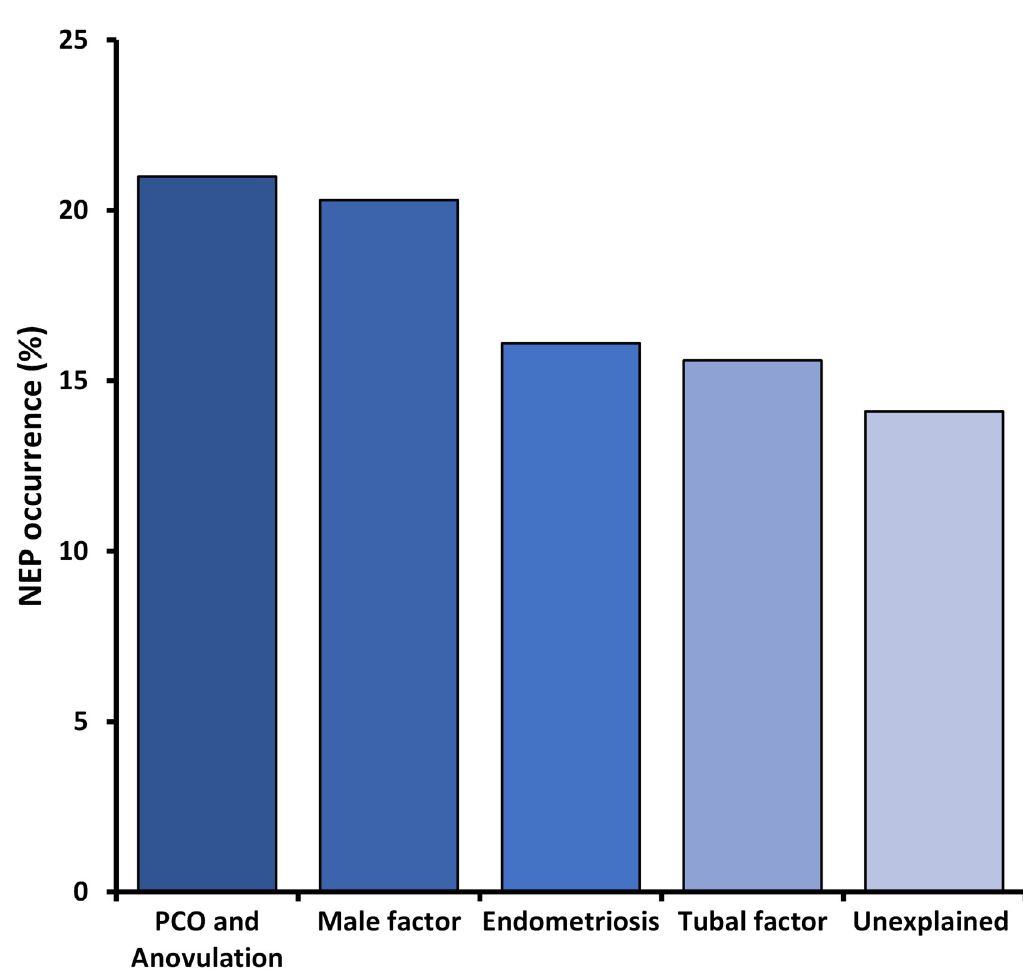
Fig 7. Nucleation error phenotype (NE) occurrence at infertility